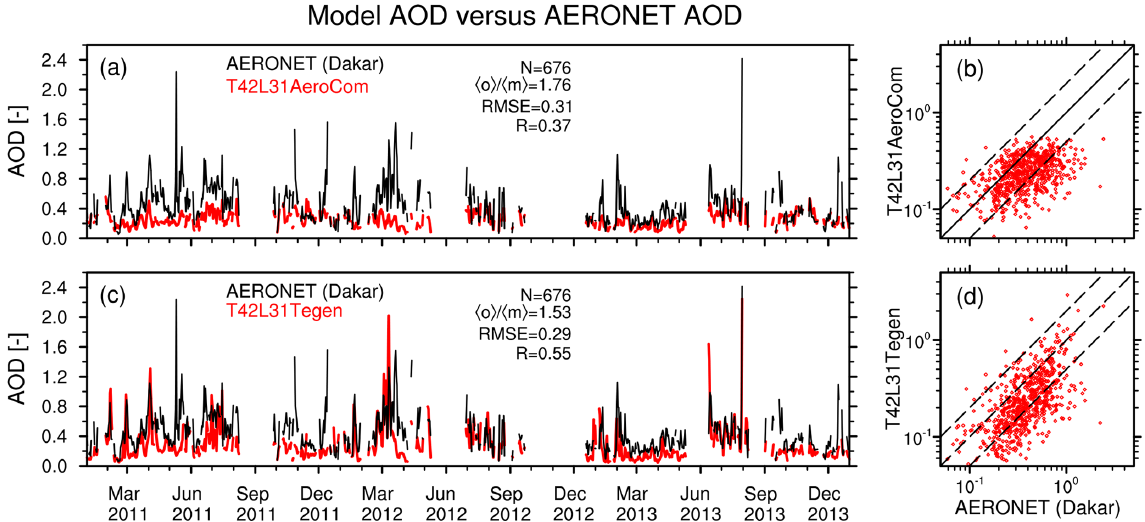
Figure 3. Model AOD vs. AERONET station observations. Time series of AOD (at 440nm) for the AERONET station located in Dakar (Senegal) are compared with model AOD on a daily mean basis for the time period January 2011–December 2013. For clarity, only a part of the full time period (starting in January 2009) is shown here. Panel (a) compares observation AOD (black line) with the offline dust model setup (T42L31AeroCom; red line). Gaps in the time series are due to missing observations on those days. Number of data points, ratio of averages of observation and model data, root mean square error (RMSE), and Pearson correlation coefficient ( R ) are shown. Panel (b) shows the data as scatterplot of model vs. observation AOD data for the T42L31AeroCom model setup. Panels (c) and (d) are the same as panels (a) and (b) but show results from the online dust model setup